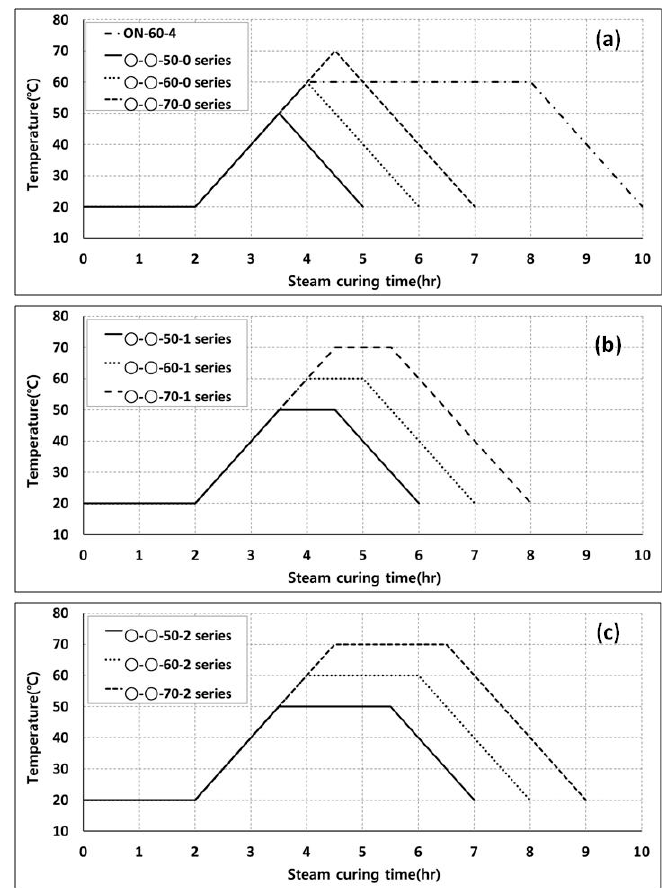
Figure 3. Steam-curing regimes employed in the experimental program; ( a ) control series and steam-curing regimen holding the maximum temperature for one hour, ( b ) steam-curing regimen holding the maximum temperature for one hour, and ( c ) steam-curing regimen holding the maximum temperature for two hours.